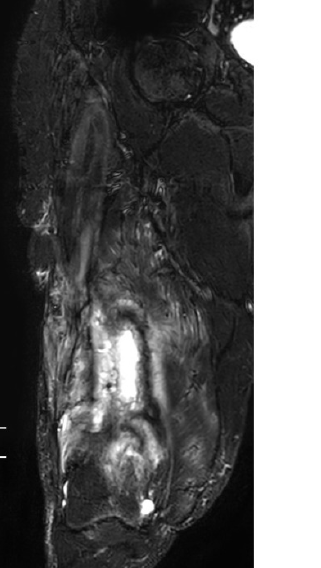
Figure 1 . MRI showing osteomyelitis right femur